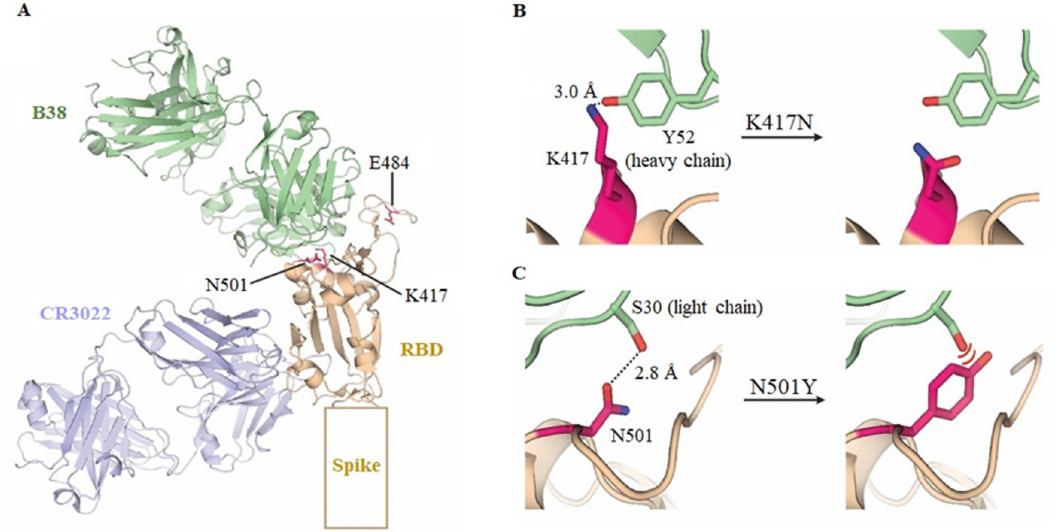
Fig 6. Structural analysis of the interactions between the SARS-CoV-2 RBD variants and mAb against SARS-CoV-2 RBD. (A) The overall structure of anti-SARS-CoV mAb CR3022 and anti-SARS-CoV-2 mAb B38 bound with SARS-CoV-2 RBD. (B) The potential mechanism of reduction in binding affinity due to the loss of an interaction in the K417N mutation in SARS-CoV-2 RBD. (C) The potential mechanism of reduction in binding affinity due to a steric clash from the N501Y mutation in the SARS-CoV-2